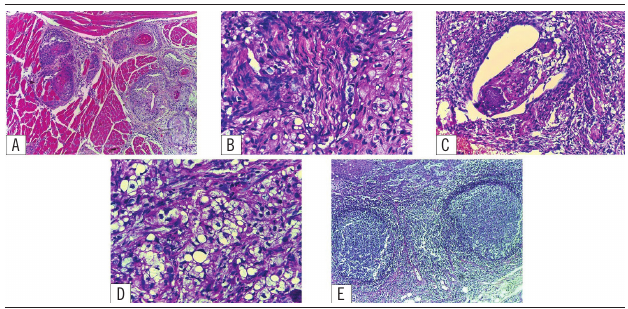
figura 3 – Other histopathological features of 80 OSCC cases diagnosed at the ISNF/UFF Oral Pathology Laboratory (HE) A) muscle infiltration (20×); B) neural infiltration (40×); C) vascular infiltration (20×); D) clear cells (40×); E) germinal centers